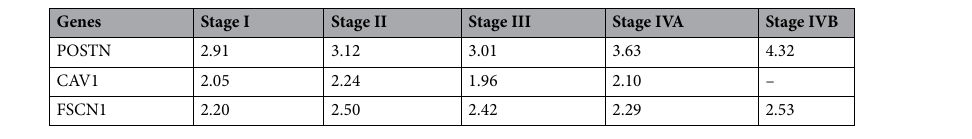
Table 6. Detailed panel of candidate OSCC genes. Fold change of RNA-Seq data (OSCC/TSCC) of genes as reported in the Cancer RNA-Seq Nexus database categorised as per staging.